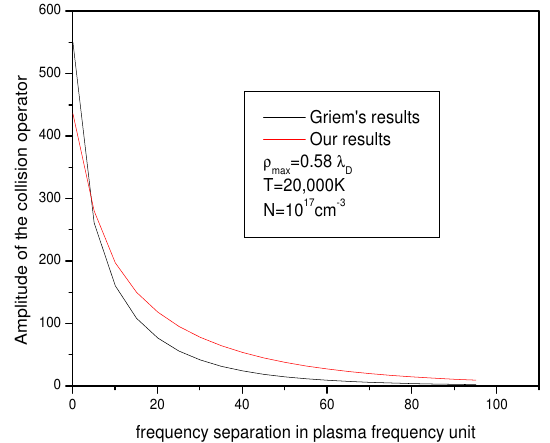
Figure 5. Amplitude of collision operator versus frequency separation in plasma frequency unit ¯ ω αα (cid:48) for Ne = 10 17 cm − 3 and a temperature 20,000 K. The amplitude is in π 2 A /768 unit where A is defined in the text as Equation (26) and ρ max = 0.58 λ D .